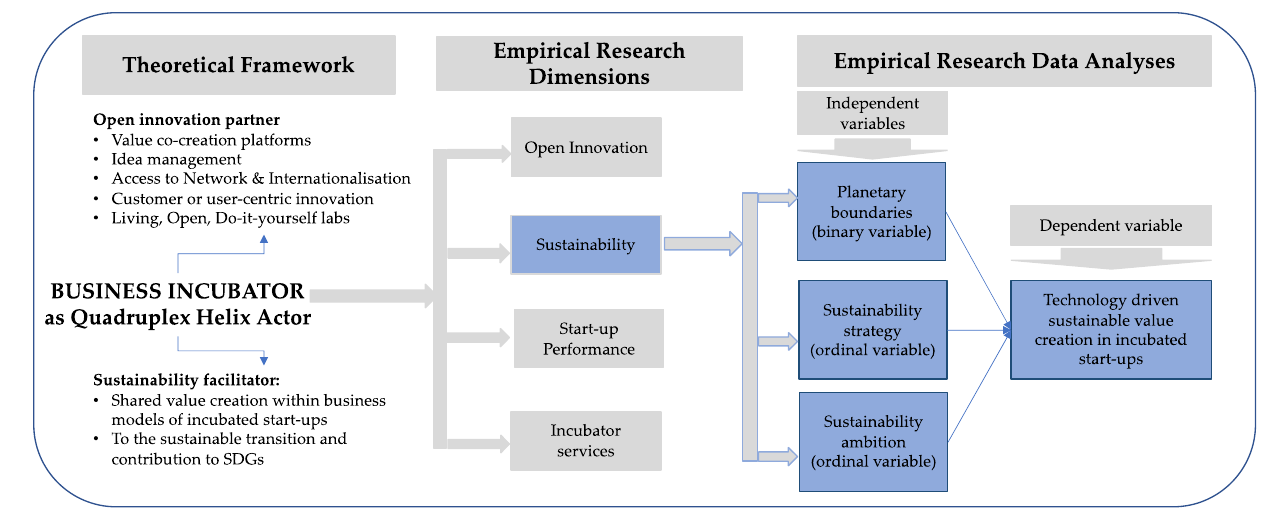
Figure 3. The theoretical conceptual model (source: the authors).